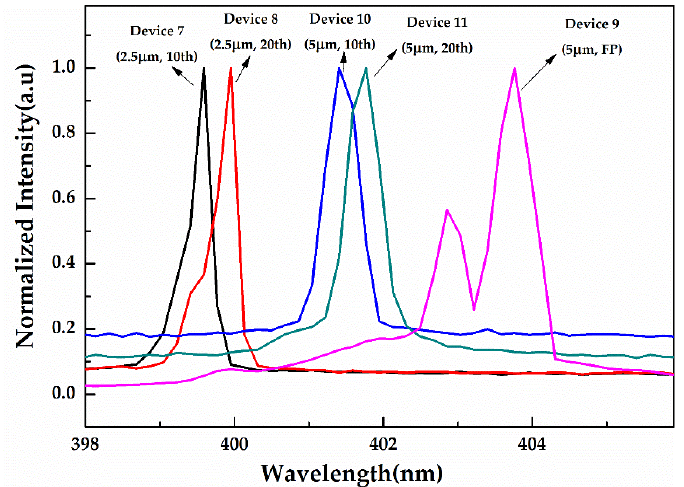
Figure 7 Emission spectrograms of processed laser diodes for Devices 7–11 driven by electrical impulses with a 500 ns pulse width and a 1 kHz repetition rate.